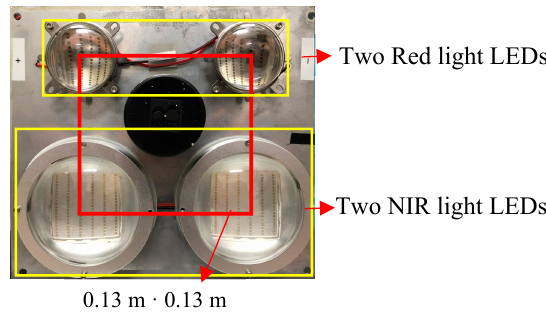
Figure 3. Active light source.